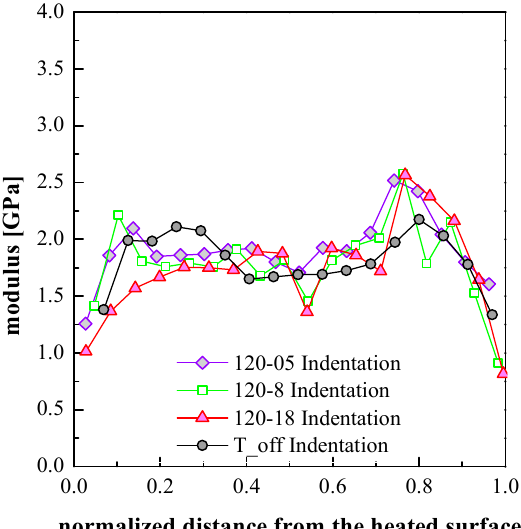
Figure 9. Elastic modulus distributions (obtained from indentation analyses) along the sample thickness for the samples T_off, 120-05, 120-8 and 120-18.